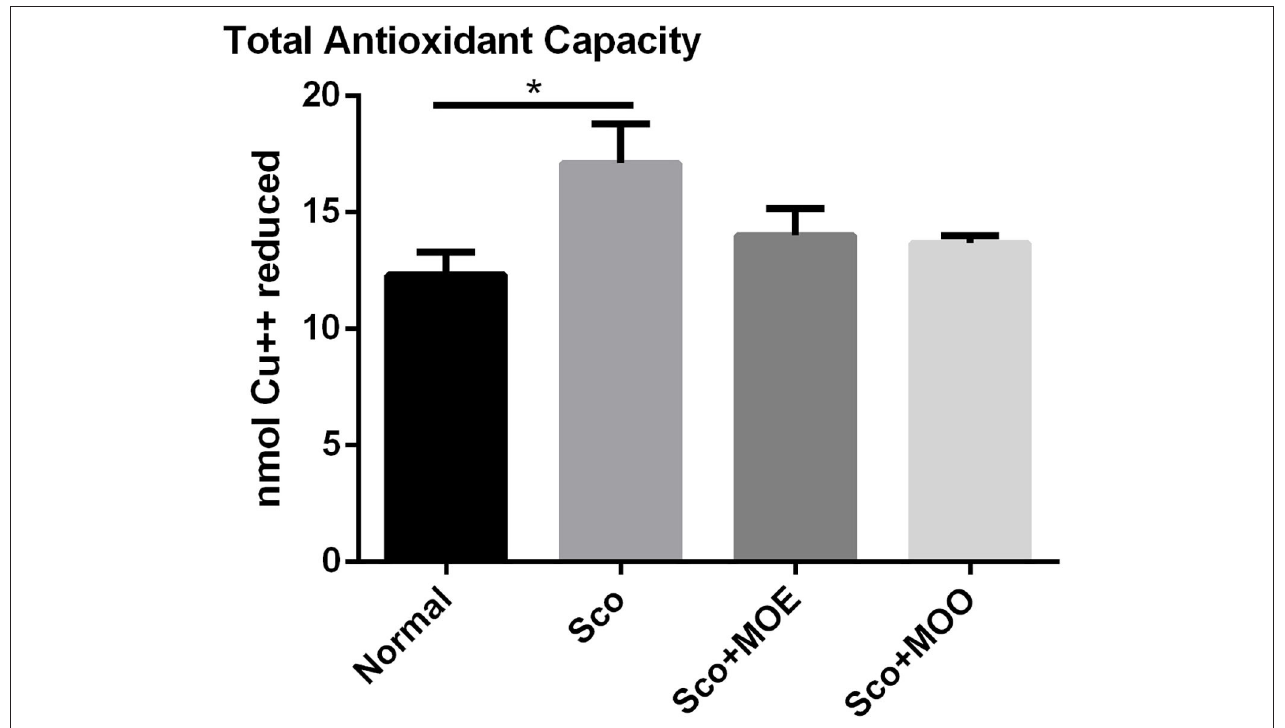
FIGURE 4 | Effects of MOE and MOO on Sco-induced memory impairment in total antioxidant capacity (TAC) in serum. Each column represents mean ± SEM of six mice. Data analysis was performed using one way ANOVA, followed by Tukey’s multi comparison test. * p < 0.05. MOE, aqueous leaves exctract of M.oleifera ; MOO, M.oleifera seed